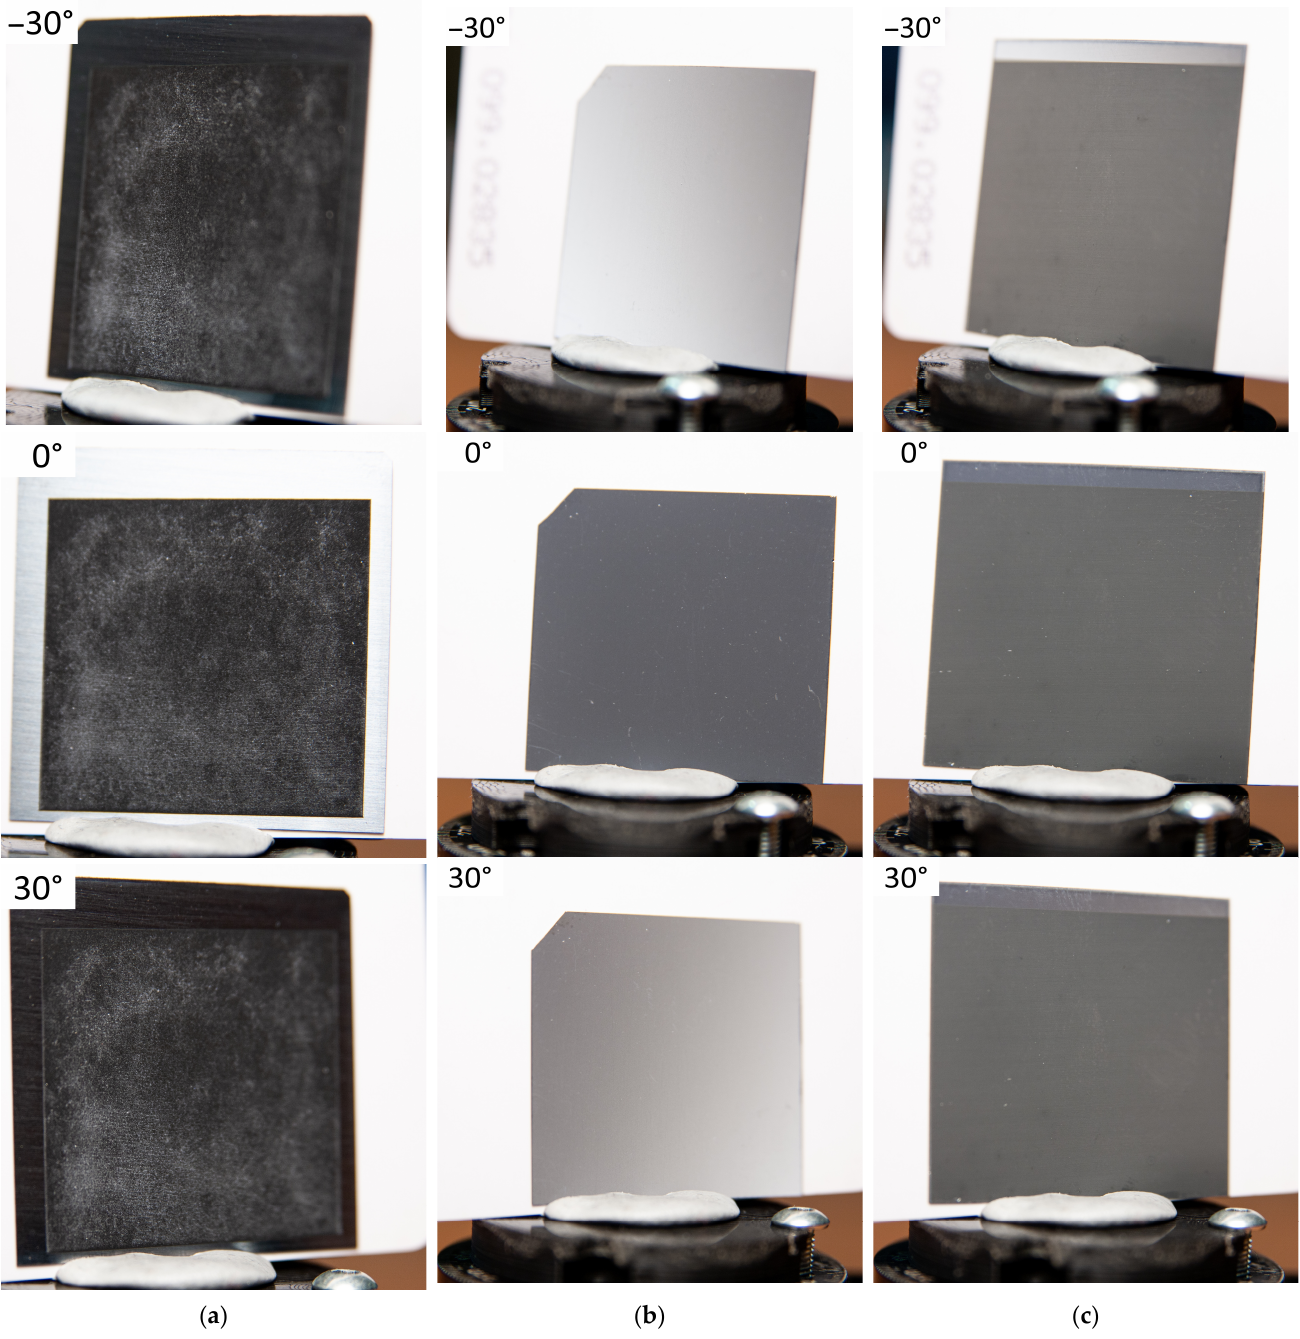
Figure 1. Optical images of processed areas of the silicon surface: ( a ) Sample #1—laser texturing of a silicon cut; ( b ) Sample #2—chemical etching; ( c ) Sample #3—hybrid chemical/laser